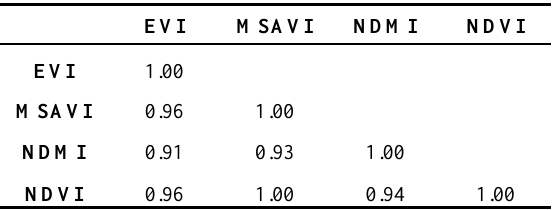
Table 3: Correlation of the slopes of trendlines of the vegetation and moisture indices with p-values <